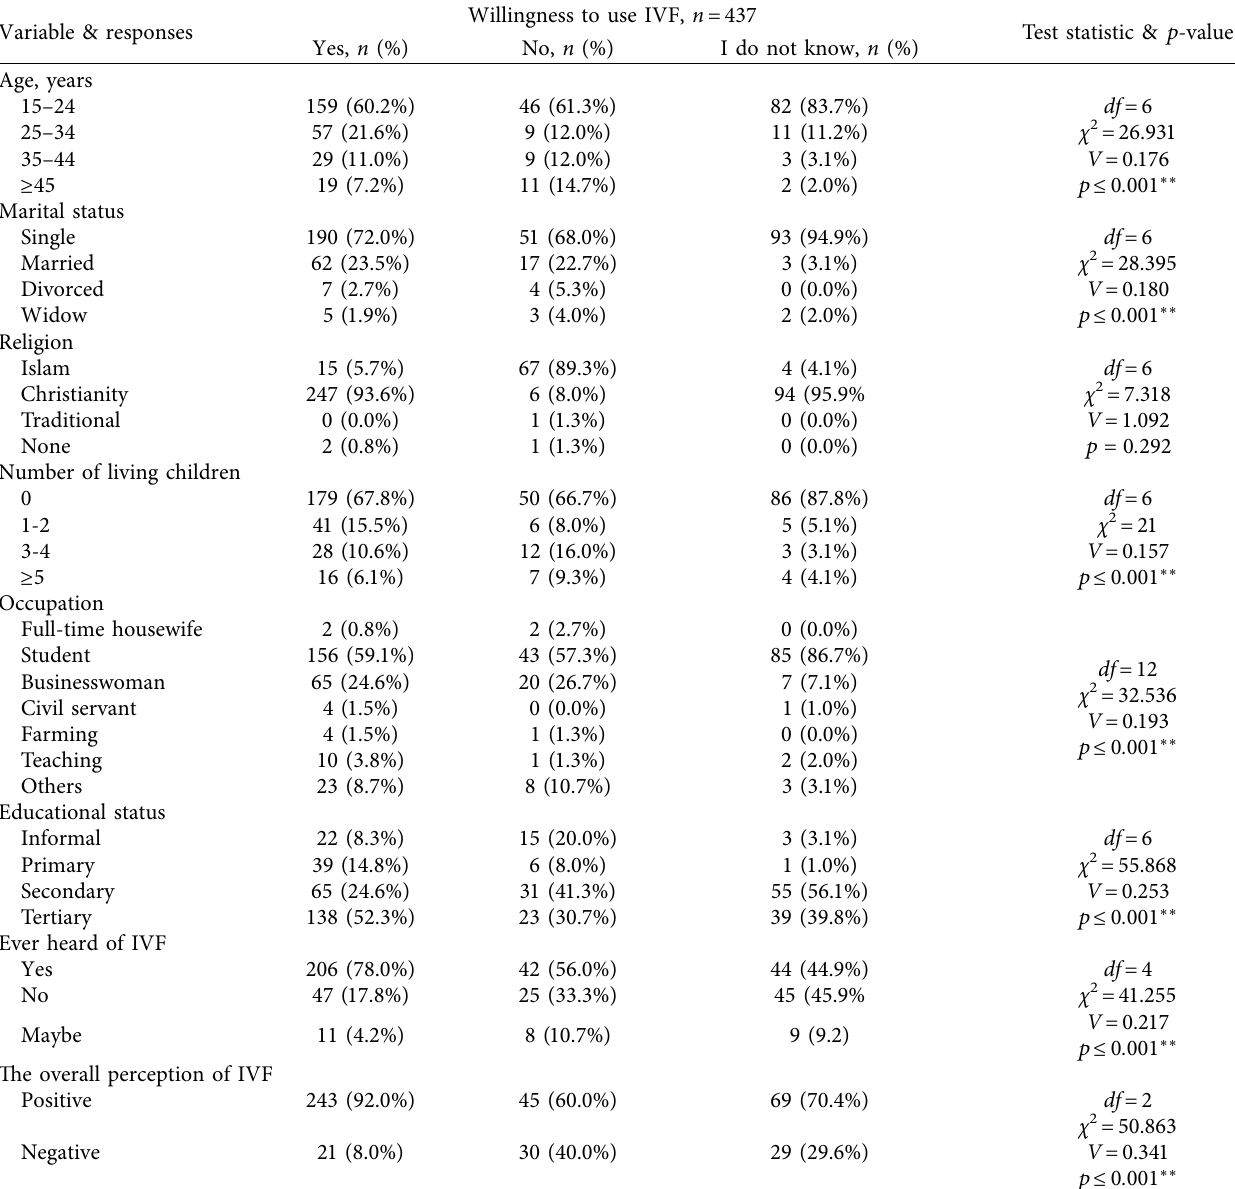
Table 8: Chi-Square test for the relationship between respondents’ background characteristics by their preparedness to utilize IVF services. Variable &